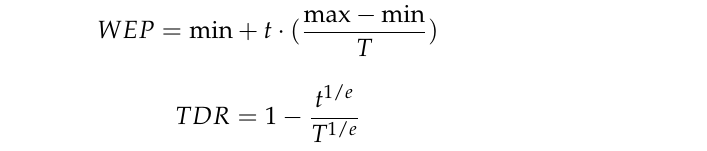
where min and max represent the minimum maximum values, respectively. t and T indicate the current iteration and the maximum iteration, respectively. e is the exploitation accuracy.